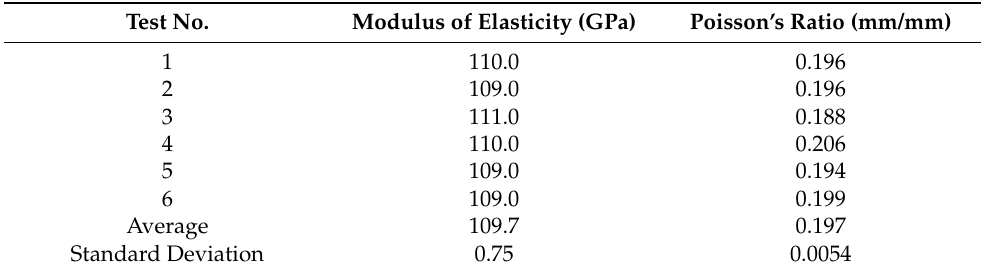
Table 7. Equivalent properties of Specimen Type III [14].